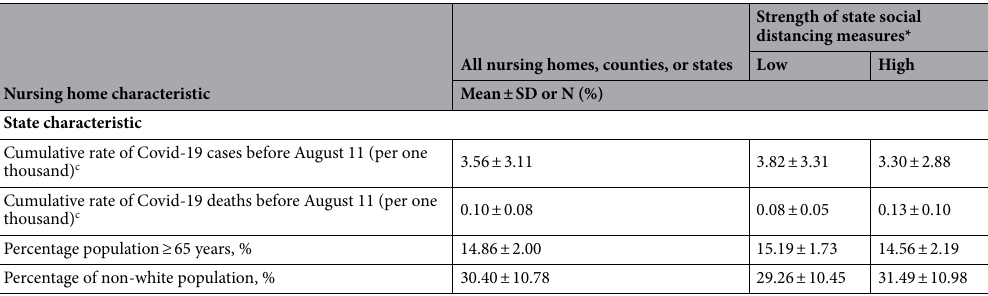
Table 1. Nursing home, county, and state characteristics by strength of state social distancing measures reported on August 11, 2020. SD standard deviation, RN registered nurse. *All p-values were < 0.001 for comparisons of group differences based on t-tests for continuous variables and chi-square tests for categorical variables, except for the following characteristics: weekly number of new non-Covid-19 related deaths among residents, three categories (p = 0.320); chain affiliated (p = 0.487); hospital affiliated (p = 0.004); and percentage of Medicaid residents (p = 0.326). a Numbers are for the reporting week ending on August 23 (Monday August